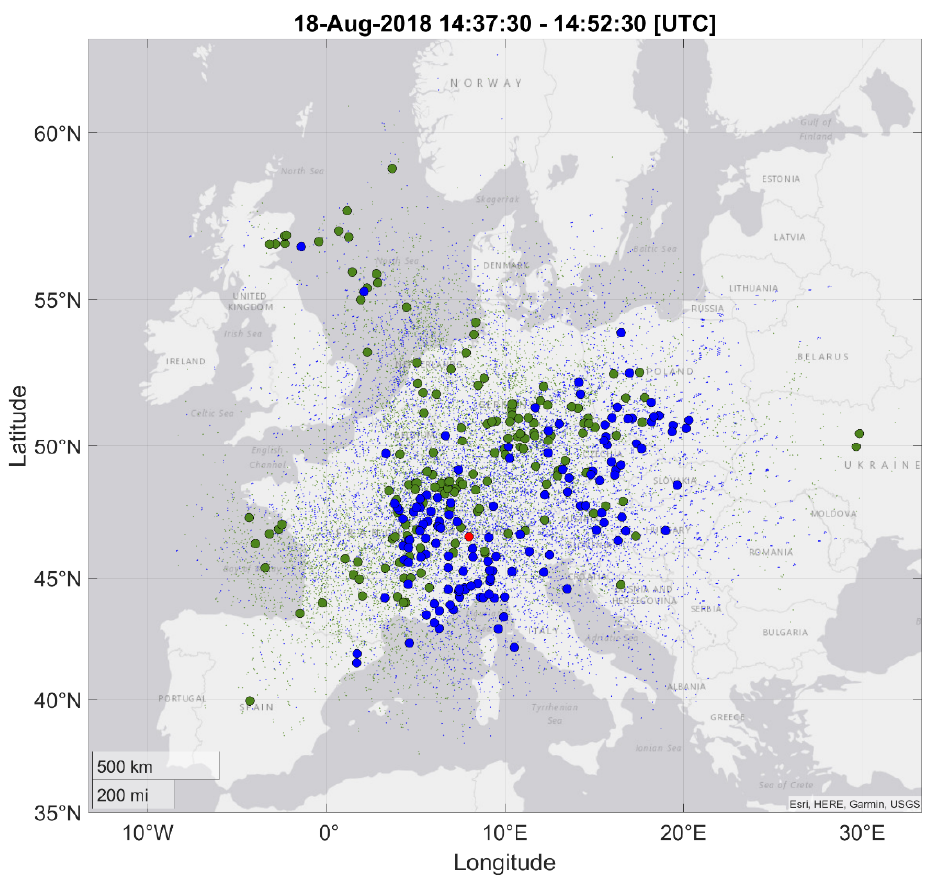
Figure 3. Example map showing the midpoints of reported signal paths from the same period as in Figure 2, plus the estimated geographical coverage of the data. Solid circles represent the midpoints of reported great circle paths. Background dots indicate the estimated geographical coverage (see text). Green = 28 MHz, blue = 50 MHz, red = 70 MHz.